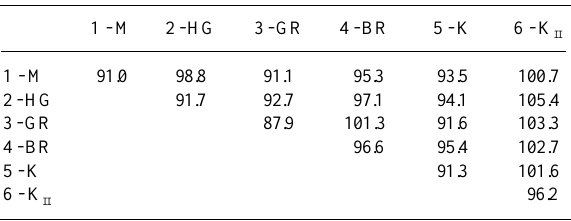
Table I - Mean grain yield (bushels/acre) of six corn populations and their hybrids 1